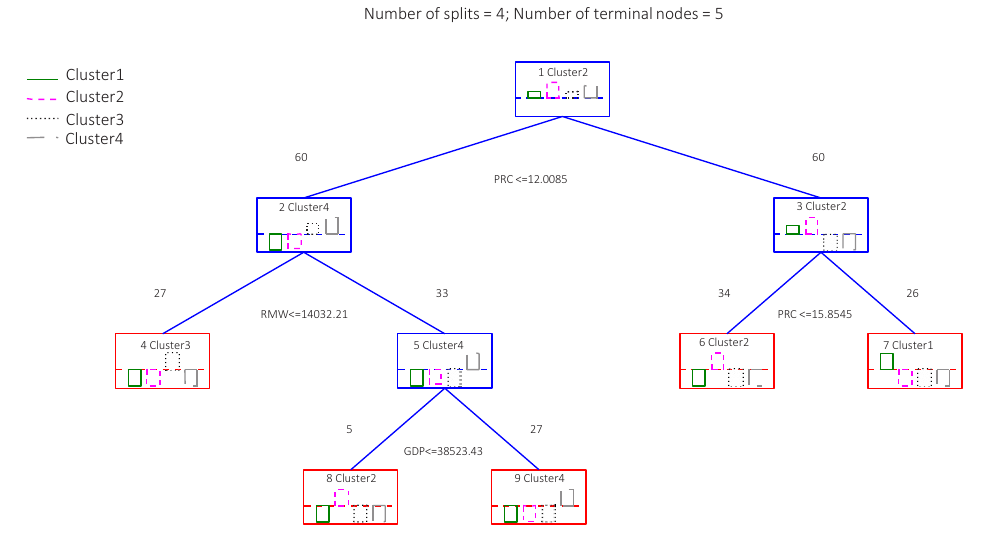
ClassificationTreefor Cluster Numberof splits= 4; Numberof terminalnodes=